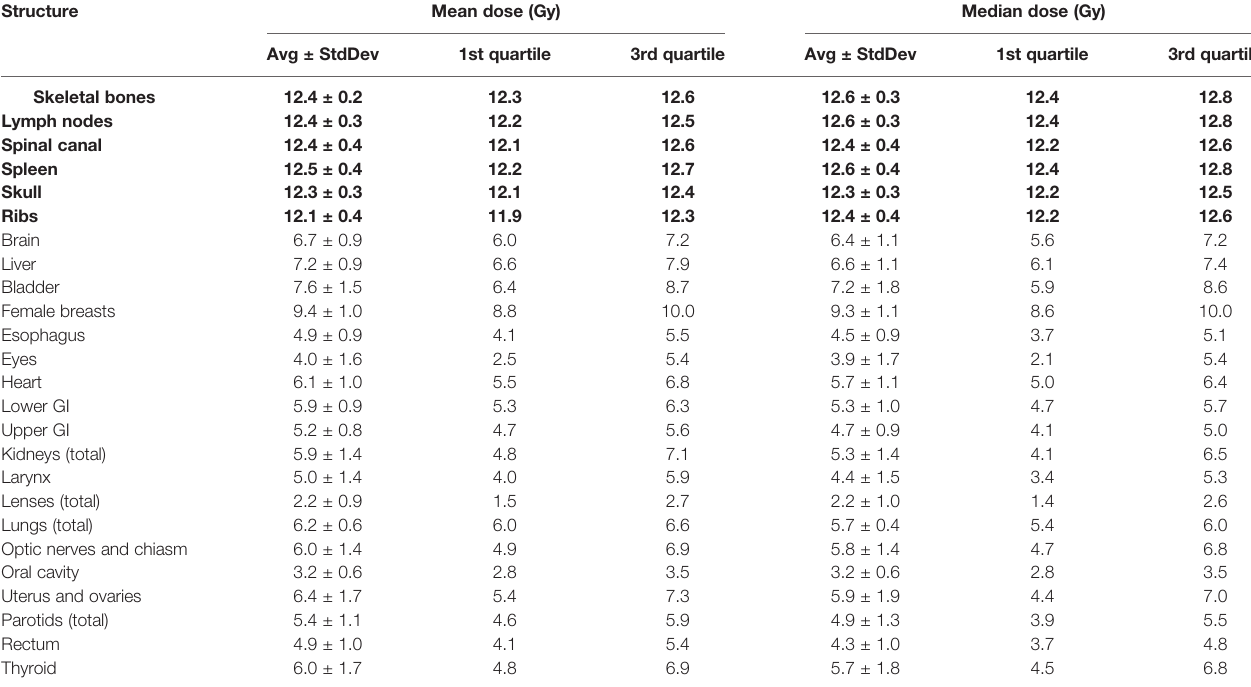
TABLE 2 | Statistics of mean dose and median dose (D50) for each structure with the 12-Gy cohort. Structure Mean dose (Gy)